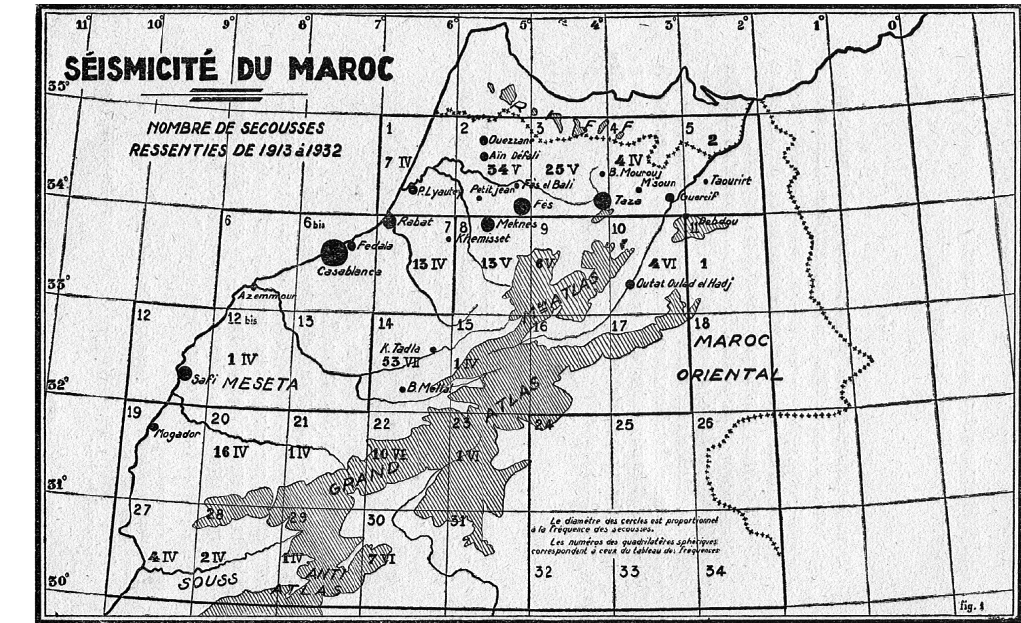
Figure 6. One of the early seismicity maps (1913–1932) of Morocco published by Debrach (1939).